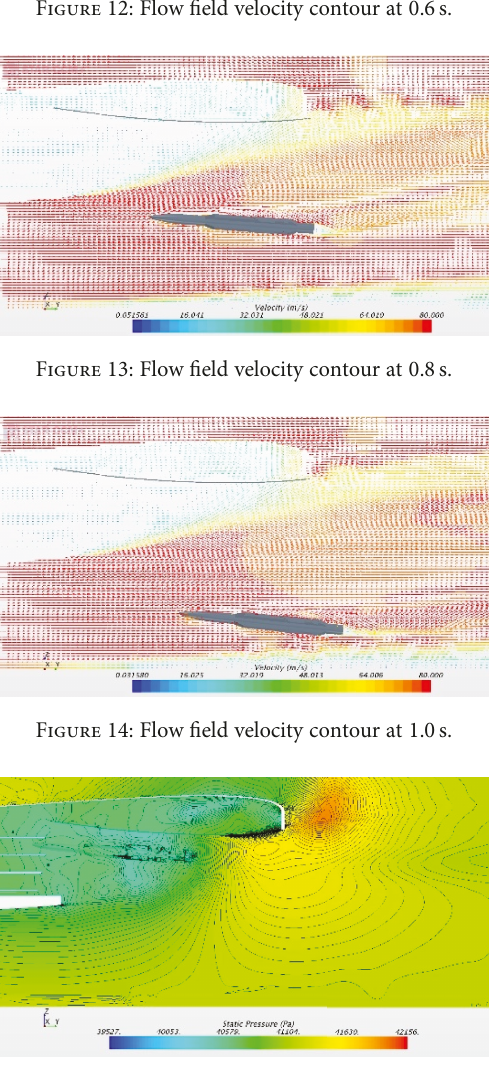
Figure 15: Flow fi eld pressure contour at 0